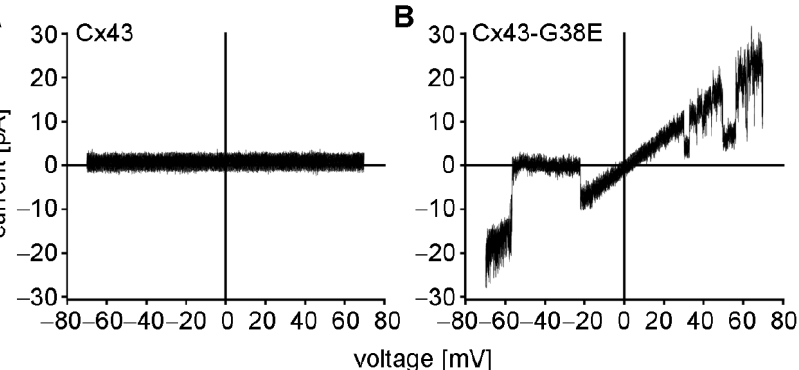
Figure 3. Patch clamp recordings from Xenopus oocytes injected with wild-type Cx43, or mutant Cx43-G38E RNAs. ( A ) Cell-attached patches obtained from wild-type Cx43 injected cells failed to display any single hemichannel activity between – 70 and +70 mV. ( B ) Cx43-G38E expressing oocytes displayed single hemichannel currents that showed transitions to the fully closed state, or sub-con-